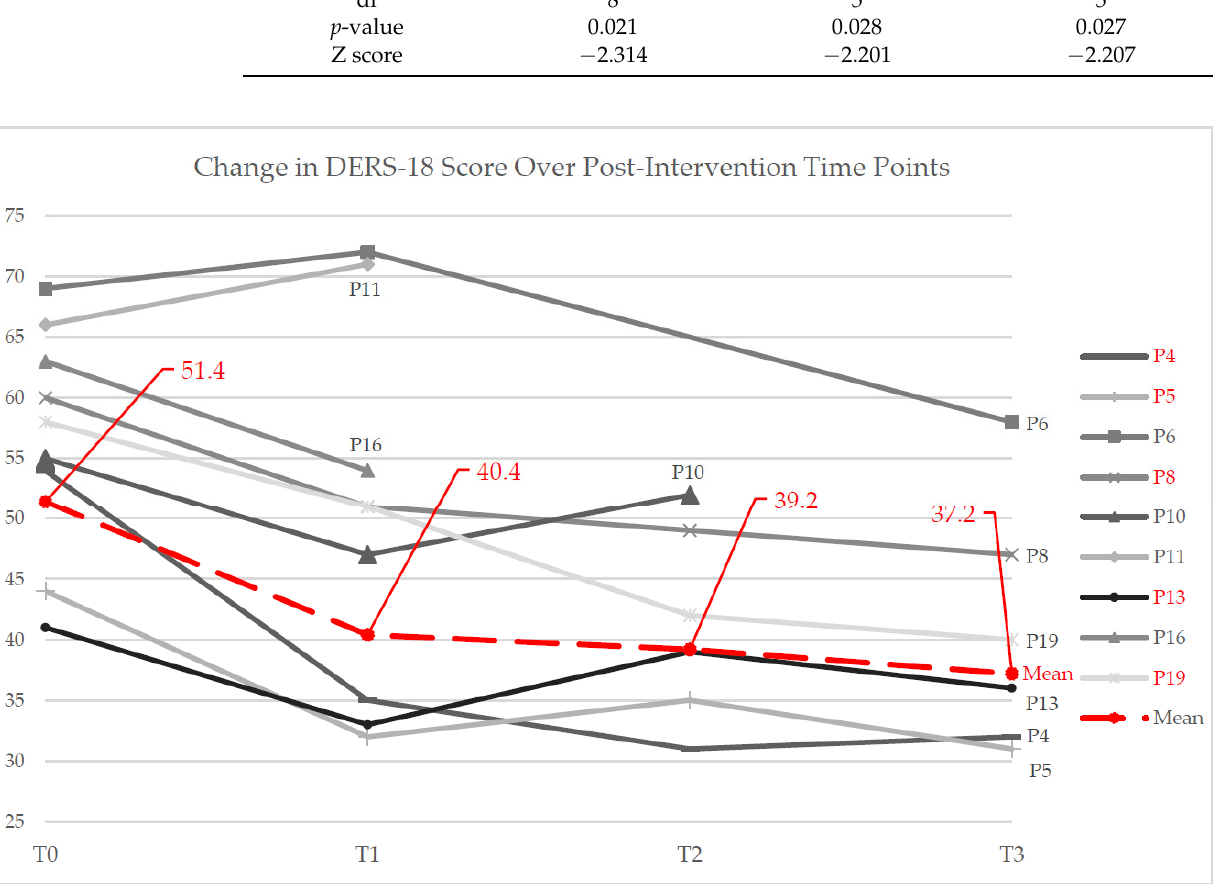
Table 2. Qualitative narrative analysis: participant quotes describing changes in ER following 3MDR intervention.